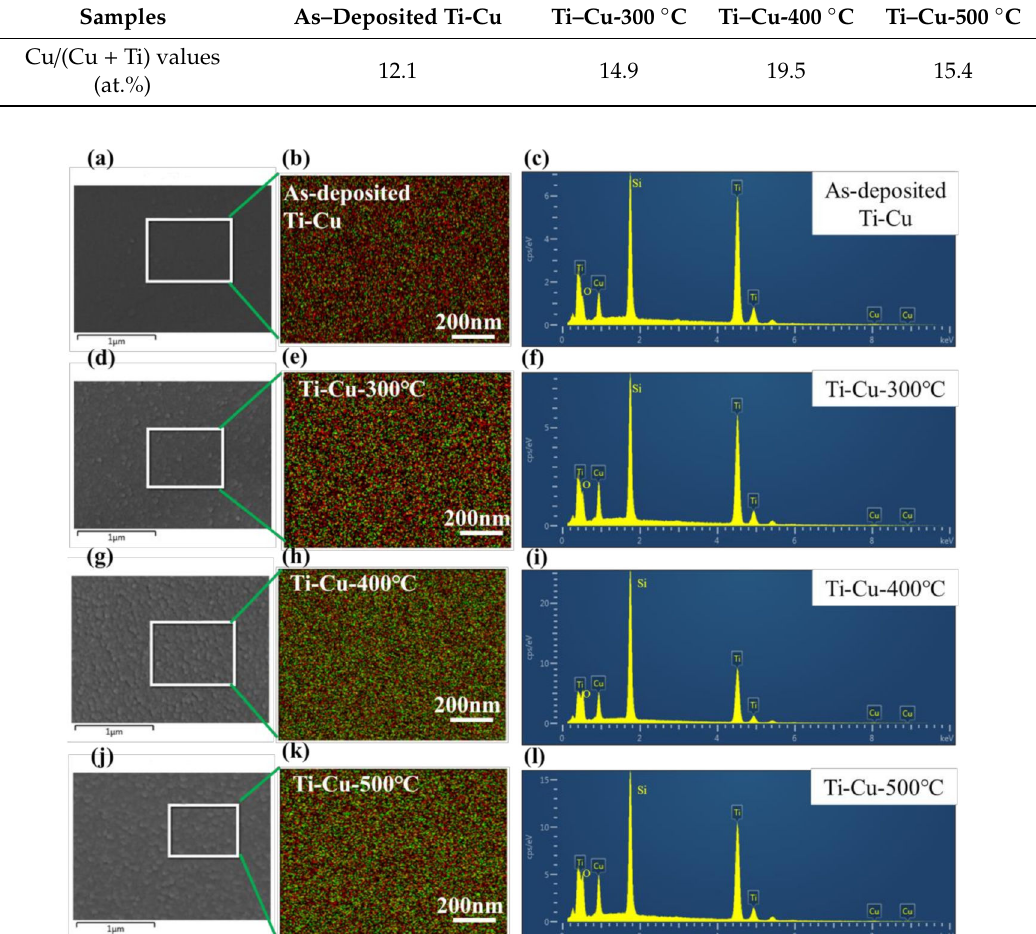
Table 1. Cu contents evaluated by EDS for the deposited and annealed Ti–Cu coatings.